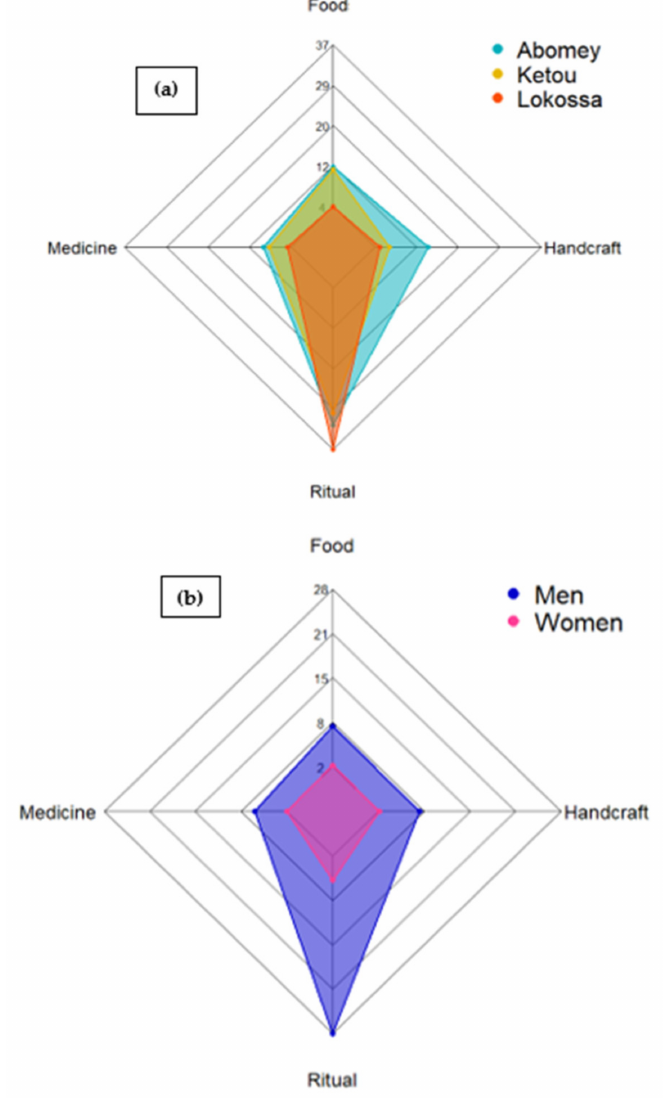
Figure 8. Radar chart showing the main effect of ( a ) district and ( b ) gender on the CI values (%) of LOTs across use